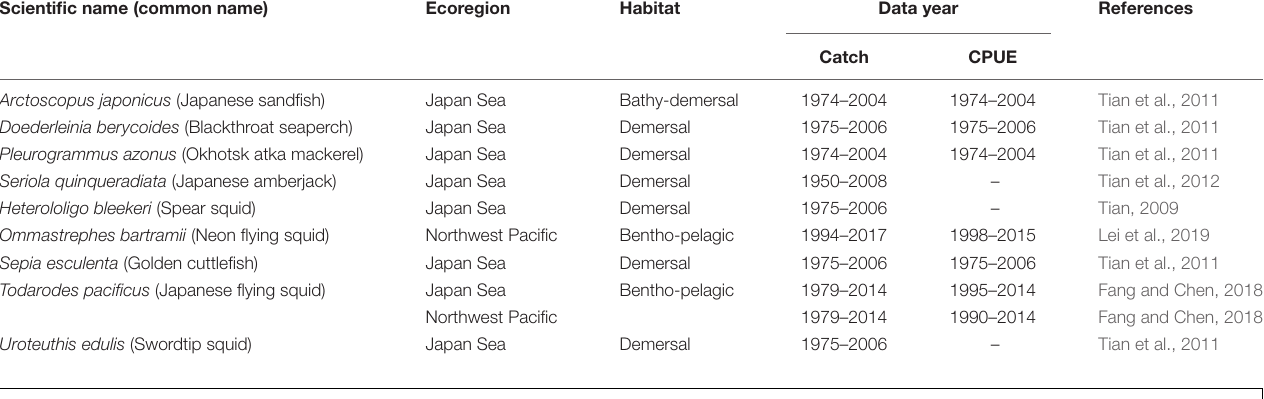
TABLE 1 | Summary of catch and CPUE data of 10 fish and cephalopod stocks in the Northwest Pacific region under assessment. Scientific name (common